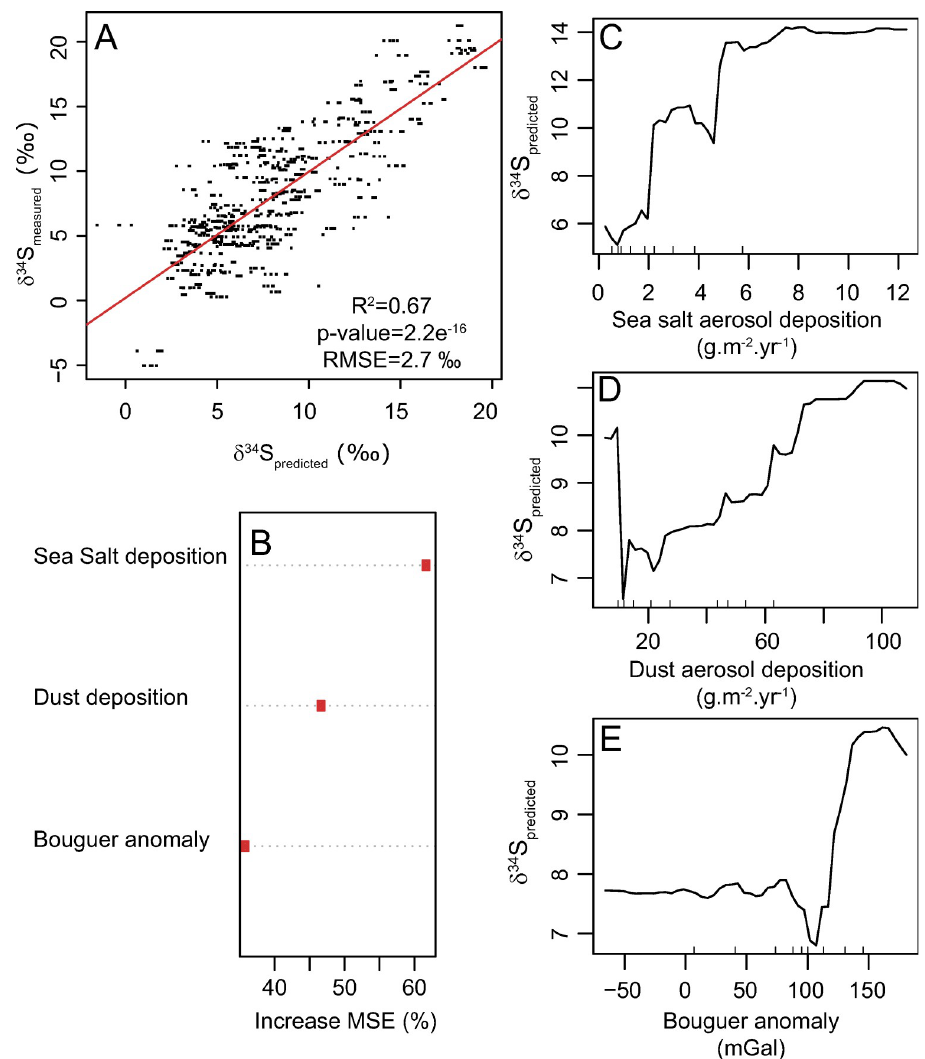
Fig 1. n-fold cross-validation and predictor for the δ 34 S random forest regression model. A: 5-fold cross-validation between predicted and measured δ 34 S values. RMSE = Root Mean Square Error. The red line is the best-fit linear model. B: Variable importance plot showing the increase in mean squared error predictions (estimated with out-of- bag-CV) as a result of the variable being permuted. Higher importance values indicate more weight as a predictor. C-E: Partial dependence plots showing the relation between each selected predictor on the predicted δ 34 S values. The R script to generate these figures is available in S1 Script.